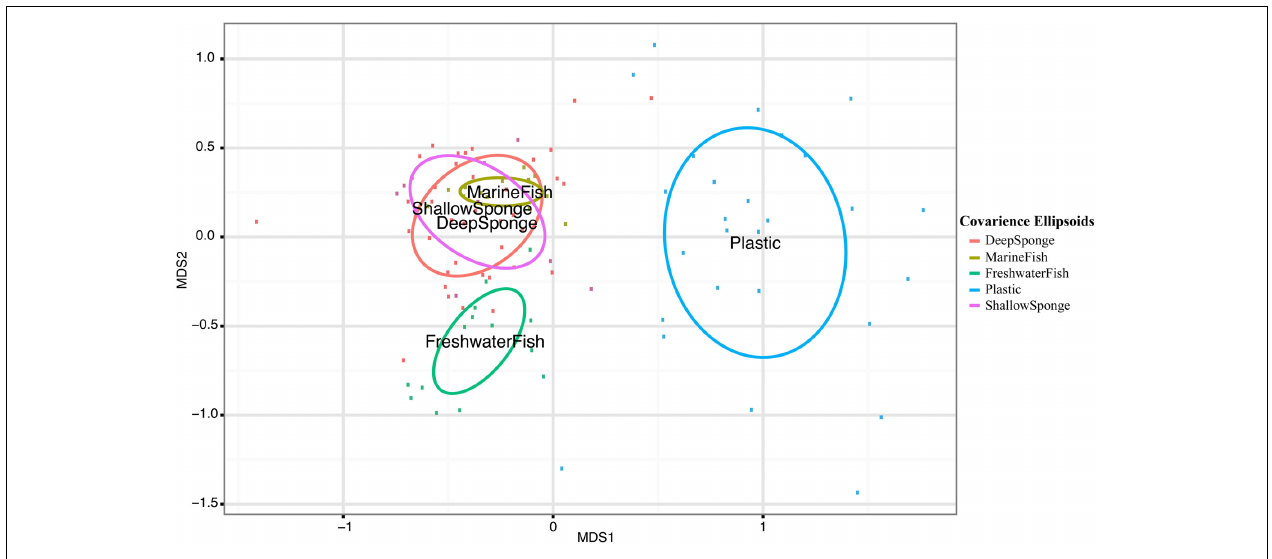
FIGURE 1 | Nonmetric Multidimensional Scaling (NMDS) plot of host-associated Vibrio communities based on oligotype distributions. Labels are located at the center of covariance ellipsoids around each host